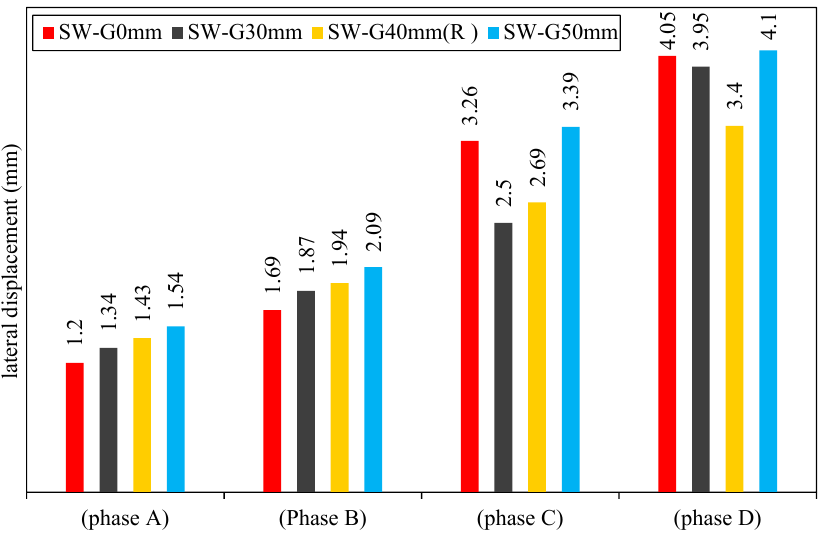
Figure 9. Lateral displacement of group 1.